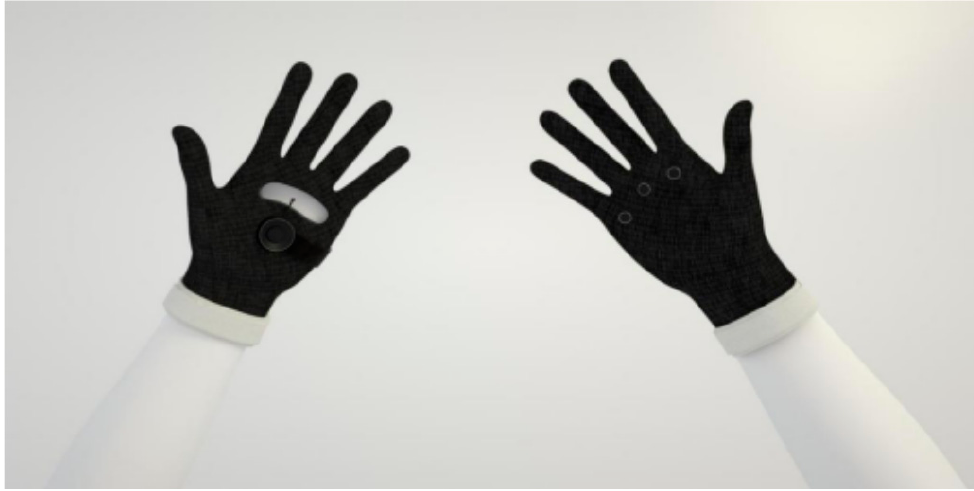
Figure 7. The design of haptic gloves.